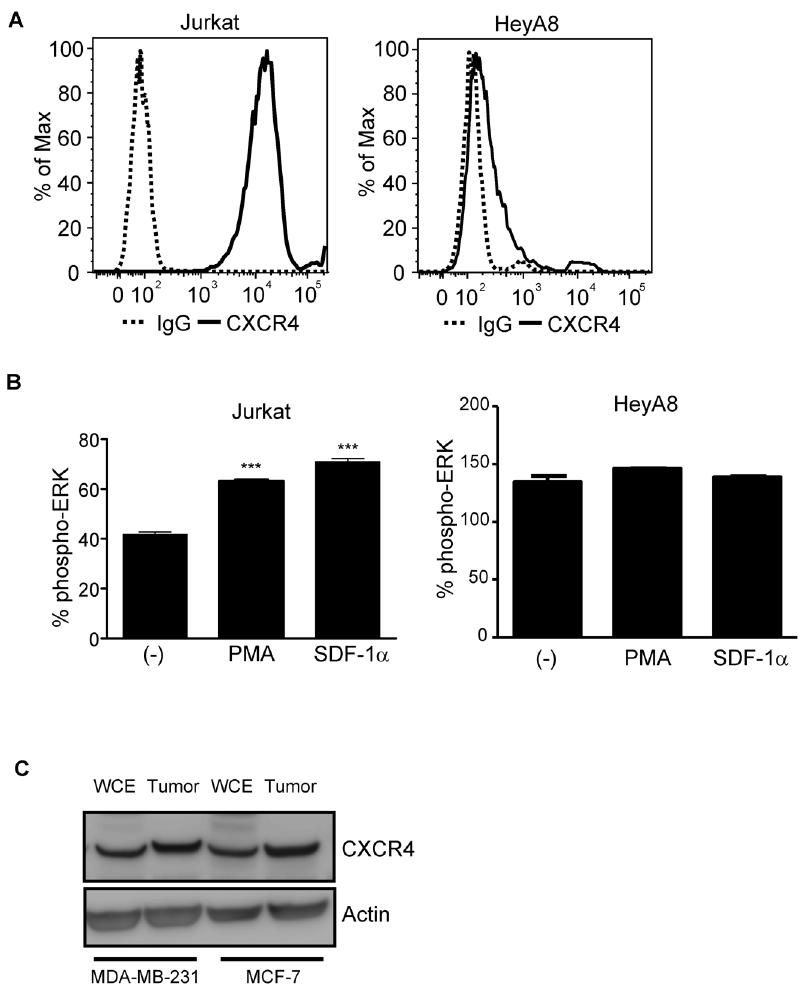
Fig. 1. HeyA8 Ovarian cell line expresses low levels of cell surface CXCR4. Jurkat and HeyA8 cells were cultured under normal growth conditions. For flow cytometry analysis, 250,000 cells per conditions were used. For phospho-ERK assay, 100,000 cells per conditions were used. ( A ) Jurkat cells showed high expression levels of surface CXCR4 (solid line) when compared to control IgG (dotted line) whereas HeyA8 ovarian cell line showed low surface CXCR4 expression. ( B ) ELISA based phospho-ERK levels when normalized to total ERK showed increased % phospho-ERK levels in Jurkat cells when stimulated with either PMA (250 ng/mL) or SDF-1 a (10 ng/mL). Phospho-ERK levels when normalized to total ERK showed no change in pERK levels in HeyA8 cells when stimulated with either PMA (250 ng/mL) or SDF-1 a (10 ng/mL). (***, P , 0.05 vs (-), 1- way ANOVA). Each bar graph is representative of at least 2 experiments. ( C ) 10 m g of protein was used for western blot analysis of breast cancer cell line MDA-MB-231 and MCF-7 where whole cell lysates and tumor extracts showed detectable CXCR4 protein